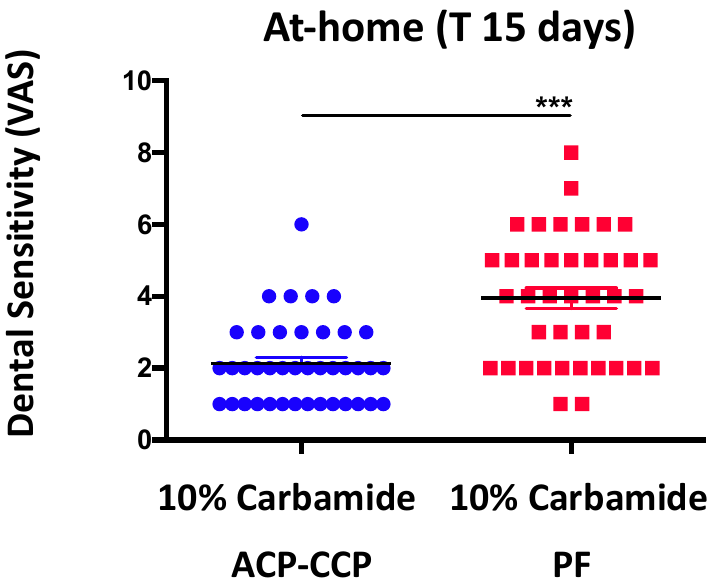
Figure 2. Effects of ACP-CPP combination on dental sensitivity, following at-home oral hygiene procedures. ACP-CPP treatment significantly reduced dental sensitivity as compared to control (PF) group, during the following 15 (T15) days. Results are showed as mean ± SEM, *** p ≤ 0.0001 .